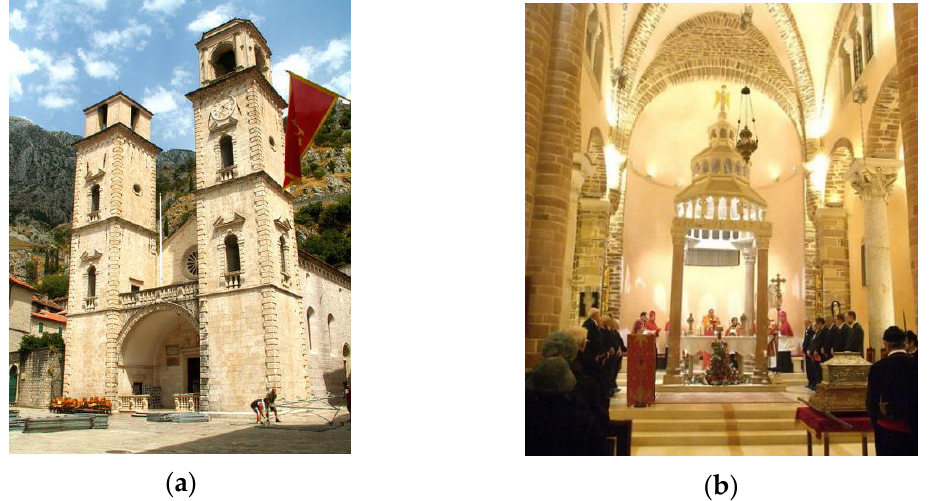
Figure 3. ( a ) Cathedral of St. Tryphon—Romanesque bells collapsed in the 1667 earthquake. ( b ) The cathedral was designed as the three-aisled basilica.